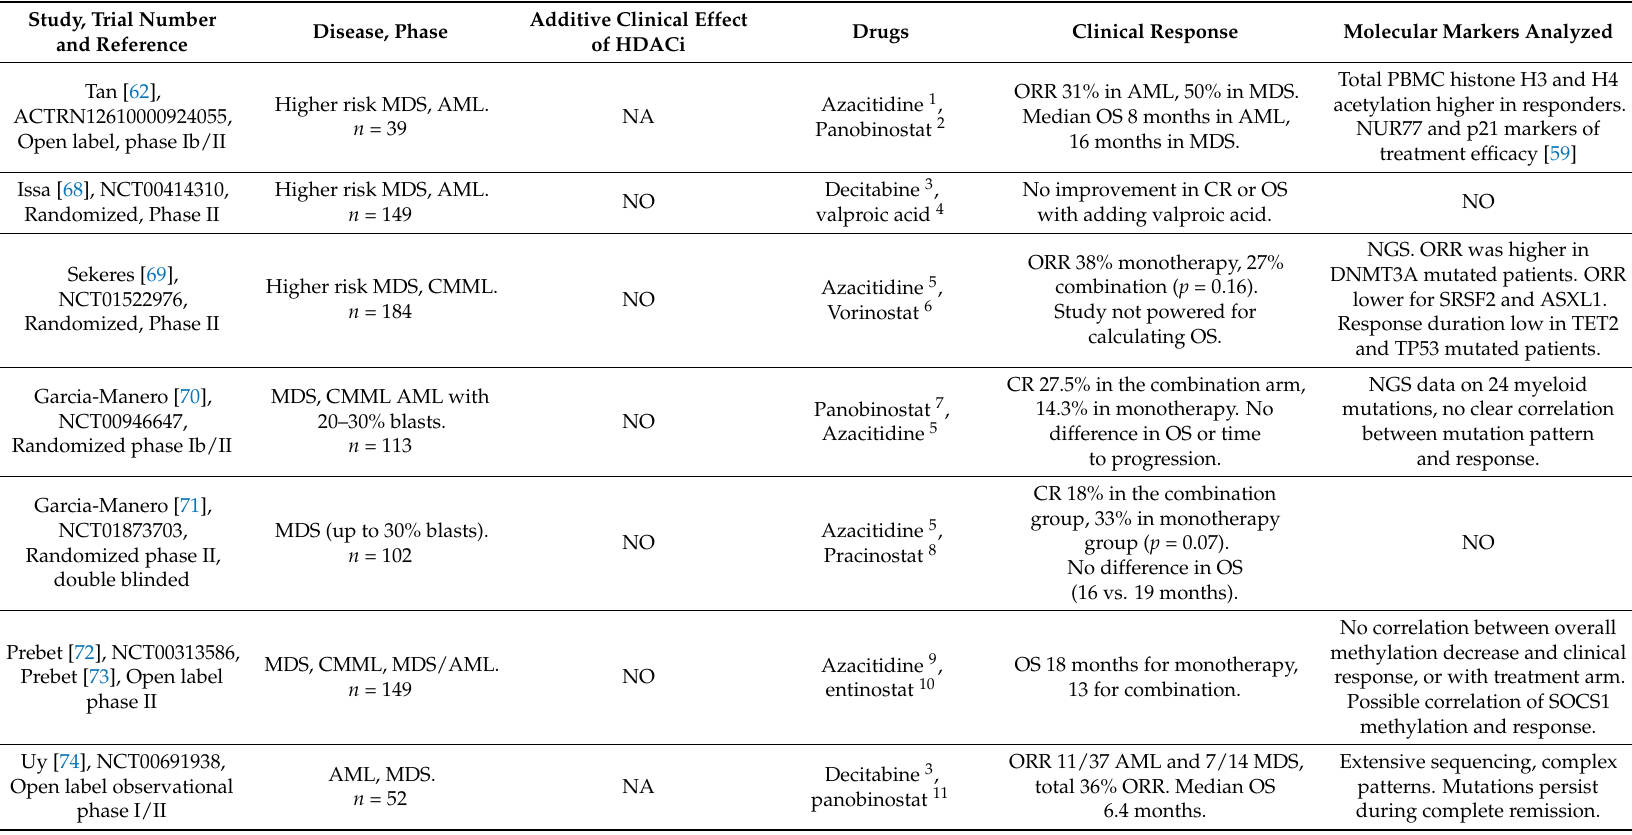
Table 2. Phase I/II trials with combination treatment of HDACi and hypomethylating agents, in AML and MDS, sometimes including CMML. OS = overall survival, ORR = overall response rate, CR = complete remission. In the studies by Uy et al., and Tan et al., there was no control arm thus a comparison of efficacy to monotherapy could not be made. Out of five evaluable studies, none showed an advantage of combination therapy. 1 Azacitidine 75 mg/m 2 Day 1–5/28, 2 panobinostat 3 days/w